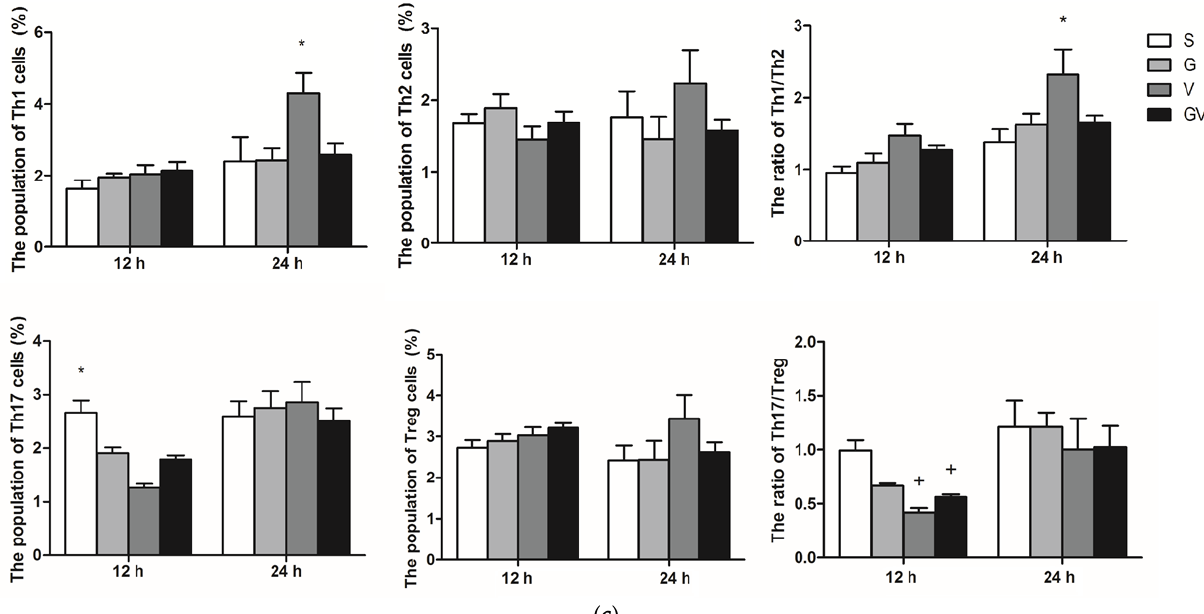
Figure 2. Representative flow cytometry plots and percentages of T helper (Th) and regulatory T (Treg) cell subpopulations in mesenteric lymph nodes (MLNs) after cecal ligation and puncture at two time points. ( a ) Gating strategy for Th type 1 (Th1), Th2, and Th17. Lymphocytes were first identified based on Side Scatter (SSC) and Forward Scatter (FSC) characteristics. Cluster-of-differentiation-4-positive (CD4+) lymphocytes were gated to analyze the percentages of interferon (IFN)- γ -expressing, interleukin (IL)-4-expressing, and IL-17-expressing CD4 T cells. ( b ) Gating strategy for Treg cells. Forkhead box p3 (Foxp3)-expressing CD4+ lymphocytes were gated to identify the percentages of Treg cells. ( c ) Percentages of Th, Th2, Th17, and Treg cell subpopulations and the ratios of Th1/Th2 and Th17/Treg. The groups are described in the legend of Figure 1 ( n = 8 in each group). Data are presented as the mean ± SEM. Differences among groups at the same time point were analyzed by a one-way analysis of variance using Tukey’s post hoc test. * Significantly differs from the other groups at the same time point. + Significantly differs from the S and G groups at the same time point ( p < 0.05).